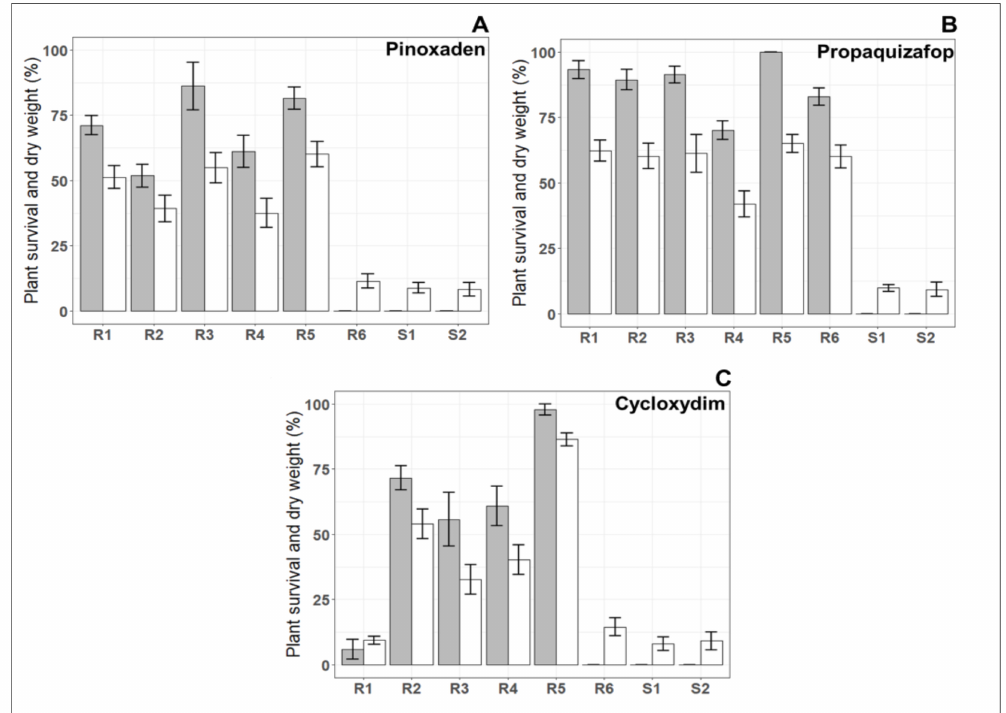
Figure 1. Survival (grey bars) and shoot dry weight (white bars), expressed as a percentage of untreated controls of susceptible (S1 and S2) and test (R1 to R6) populations of A. fatua to ACCase inhibitors pinoxaden ( A ), propaquizafop ( B ) and cycloxydim ( C ) applied at recommended field rate, corresponding to 30, 100 and 150 g ha − 1 , respectively. Vertical bars indicate standard